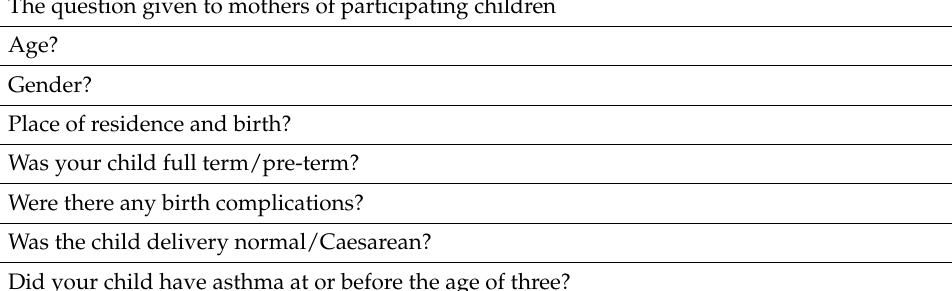
Table 1. Questionnaire given to participants’